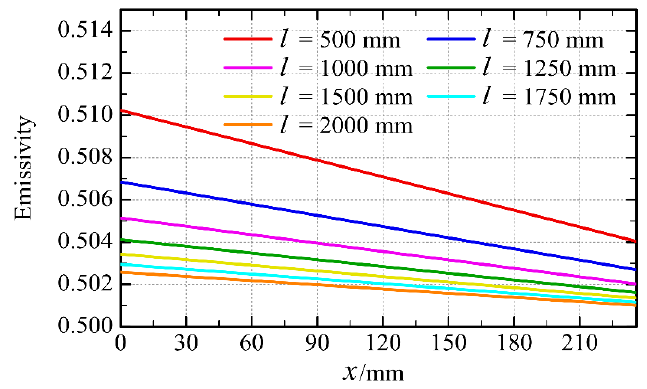
Figure 13. Corrected emissivity calculation results at different distances l . The changes in the average relative error and the maximum relative error of the corrected emissivity with l are shown in Figure 14.